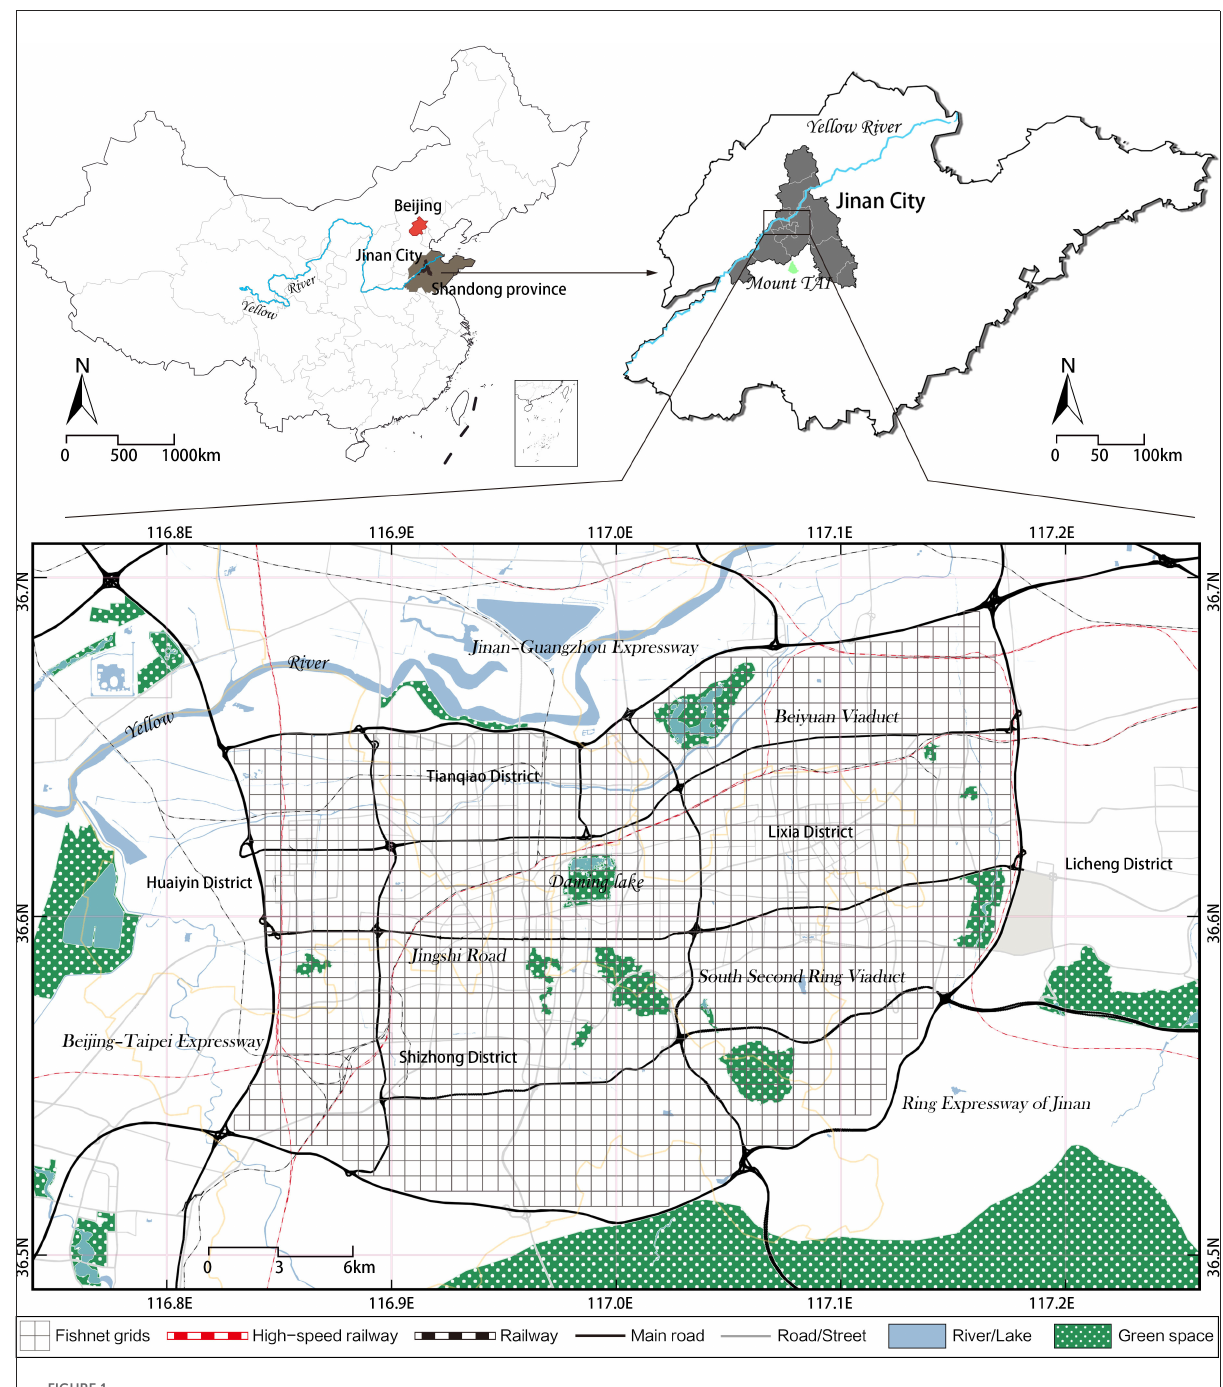
FIGURE1 Location of the study area.